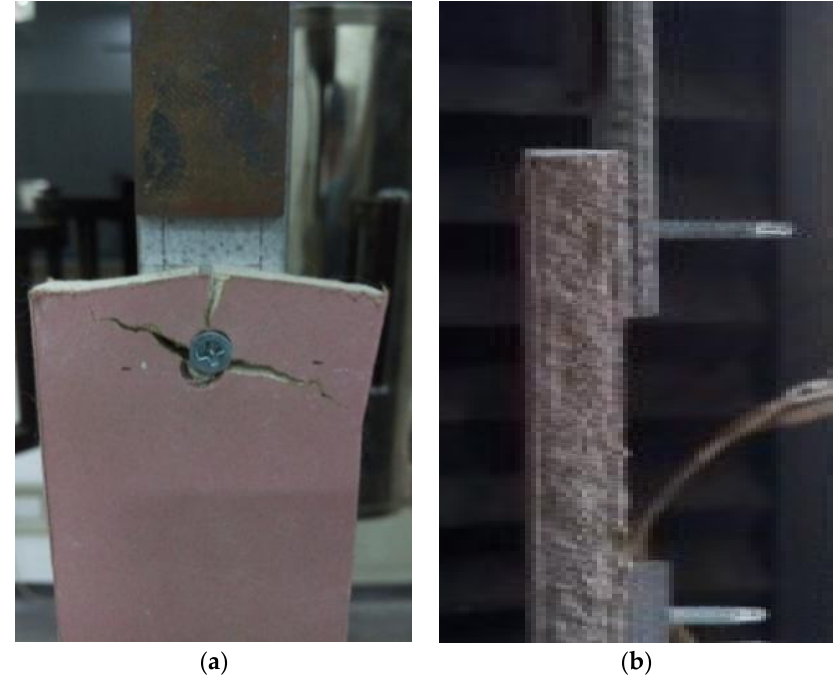
Figure 6. Breaking of the loaded sheathing edge for GPB15S ‐ 20: ( a ) front view; and ( b ) side view.